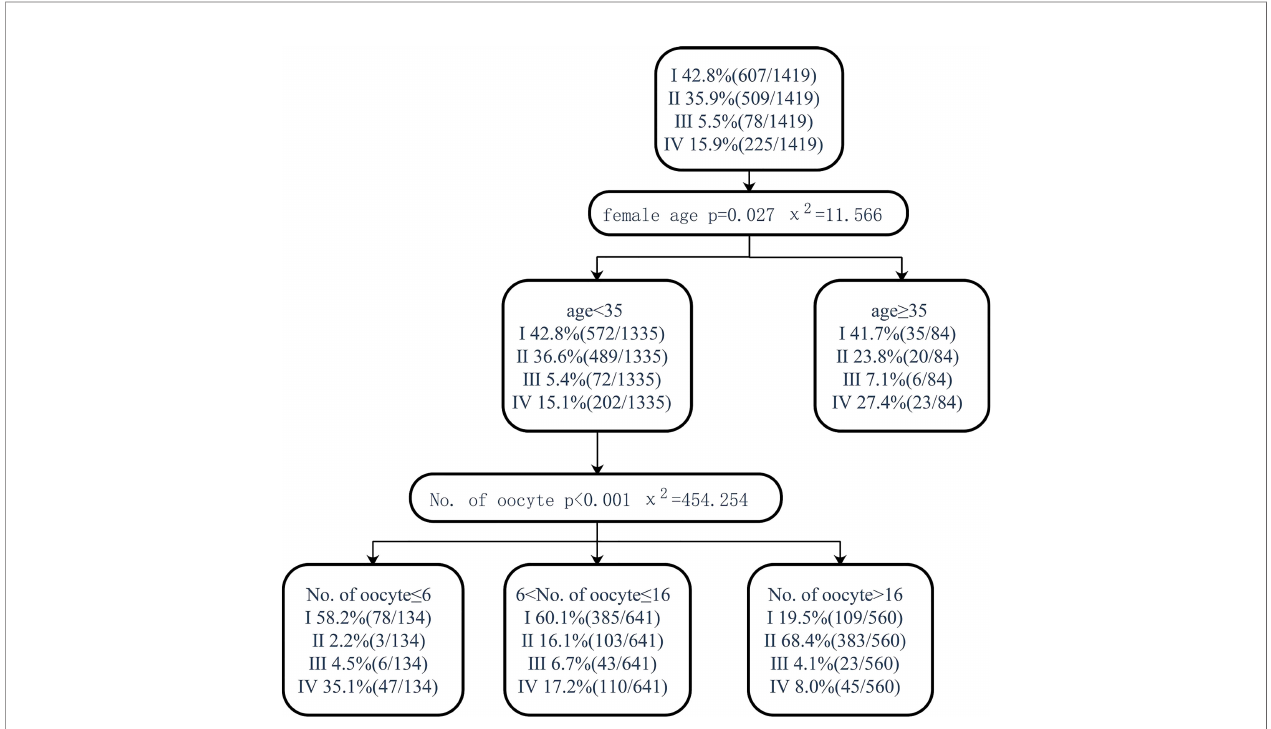
FIGURE 5 | Decision tree on pregnancy after fresh embryo transfer. I, clinical pregnancy after fresh embryo transfer; II, clinical pregnancy after the fi rst transfer using frozen embryo; III, clinical pregnancy after multiple embryo transfers; IV, no clinical pregnancy after embryo exhaustion.